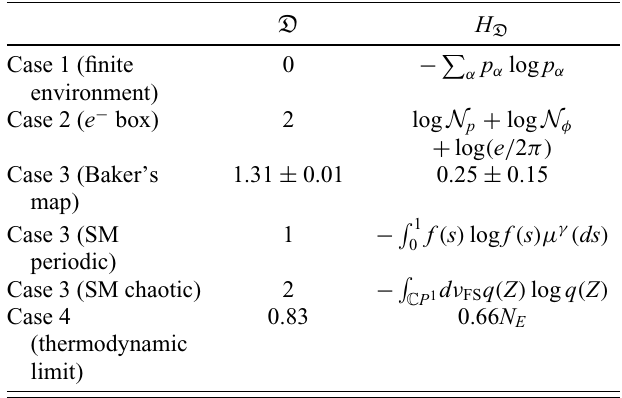
TABLE I. Quantum information dimensions and dimensional quantum entropies for the geometric quantum states analyzed